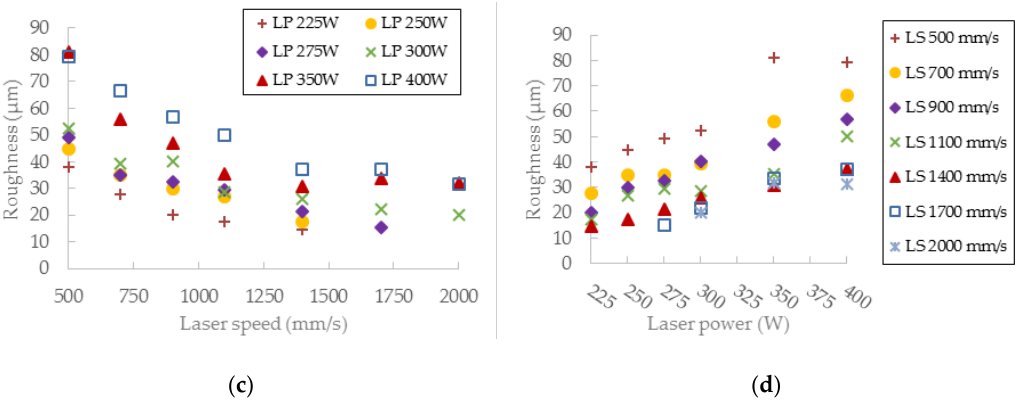
Figure 13. ( a ) The influence of various laser speed (LS) levels on porosity; ( b ) the influence of various laser power ( LP) levels on porosity; ( c ) the influence of various LS levels on surface roughness; ( d ) the influence of various LP levels on surface roughness.